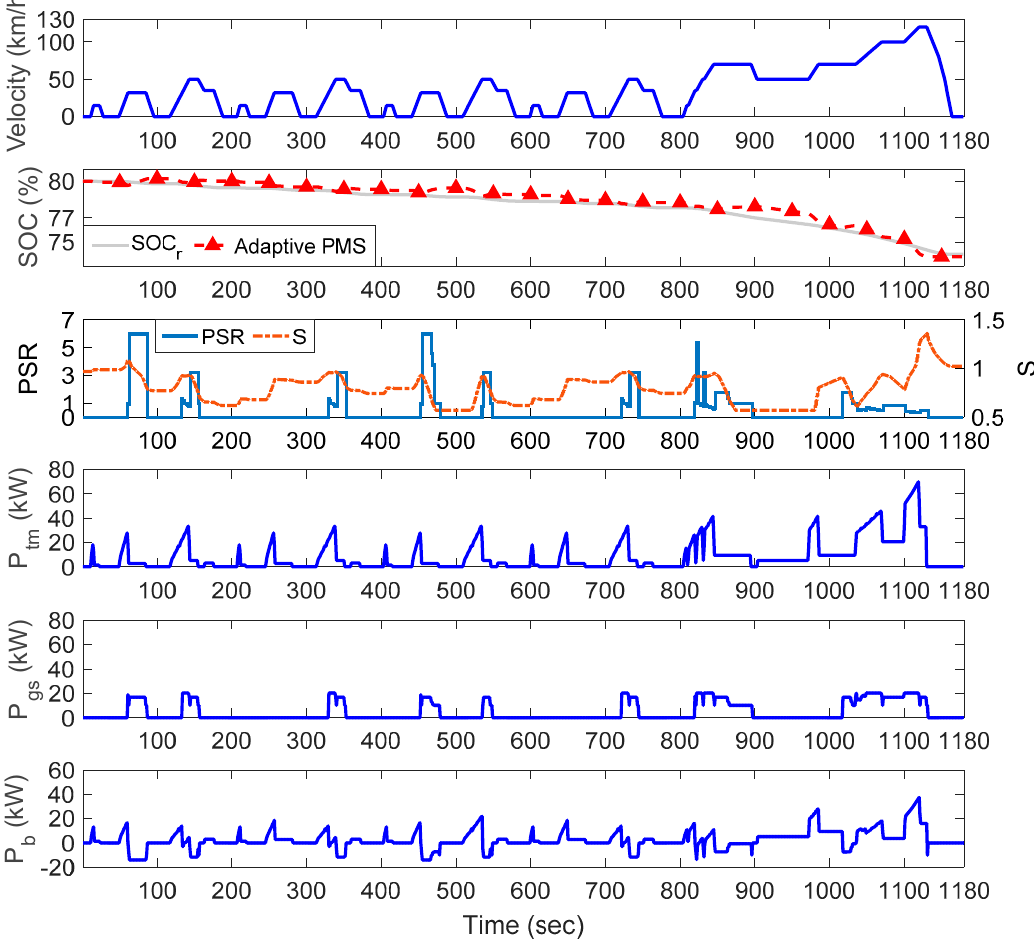
Figure 15. Simulation results for the 1st NEDC.